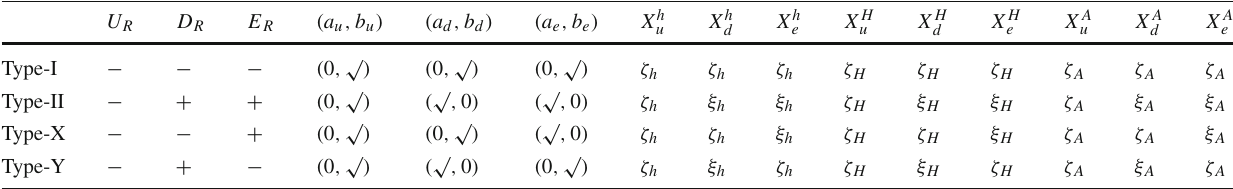
Table 1 Charge assignment for right-handed fermions under the C 2 symmetry in the C2HDM. All the left-handed fermions Q u transformed as even under C 2 . In the third column, the symbol